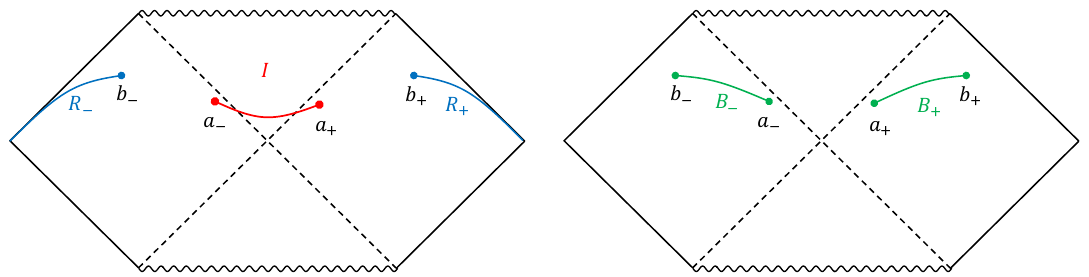
Figure 1 . The entanglement entropy of the Hawking radiation is identified with that in the region R = R + ∪ R − (left). After the Page time, the island I appears as a consequence of the replica trick in gravitational theories. The region of the black hole B = B + ∪ B − is naively the complement of R ∪ I (right), which includes a region which is added by a similar mechanism to that for the island (see figure 3(right)). The boundaries between R and B , b ± are introduced by hand, while those of the island, a ± are determined by the prescription of the quantum extremal